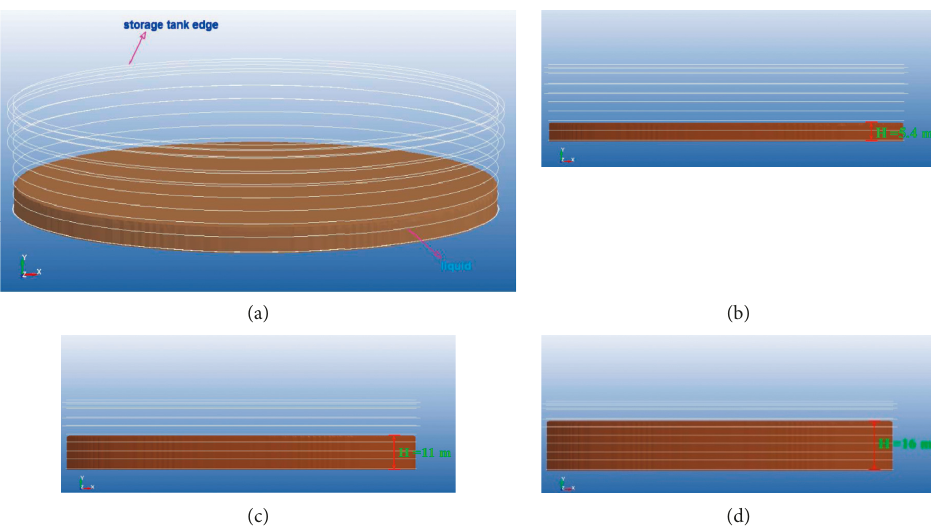
Figure 8: The liquid level conditions. (a) Tank edge and liquid. (b) 25% fill level (( H ) (( H ) liquid � 11meters). (d) 75% fill level (( H ) liquid � 16meters).